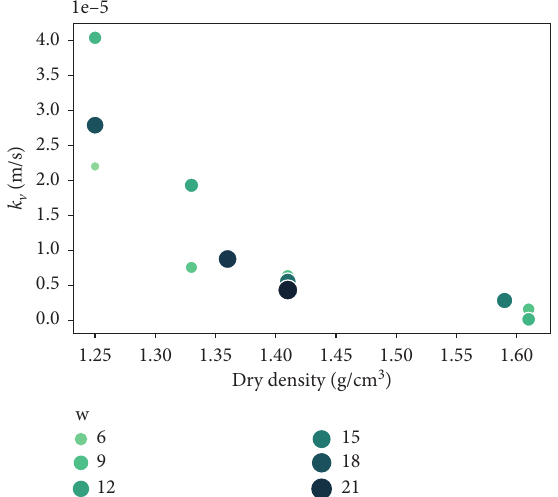
Figure 13: Scatter plot of permeability coefficient of remolded